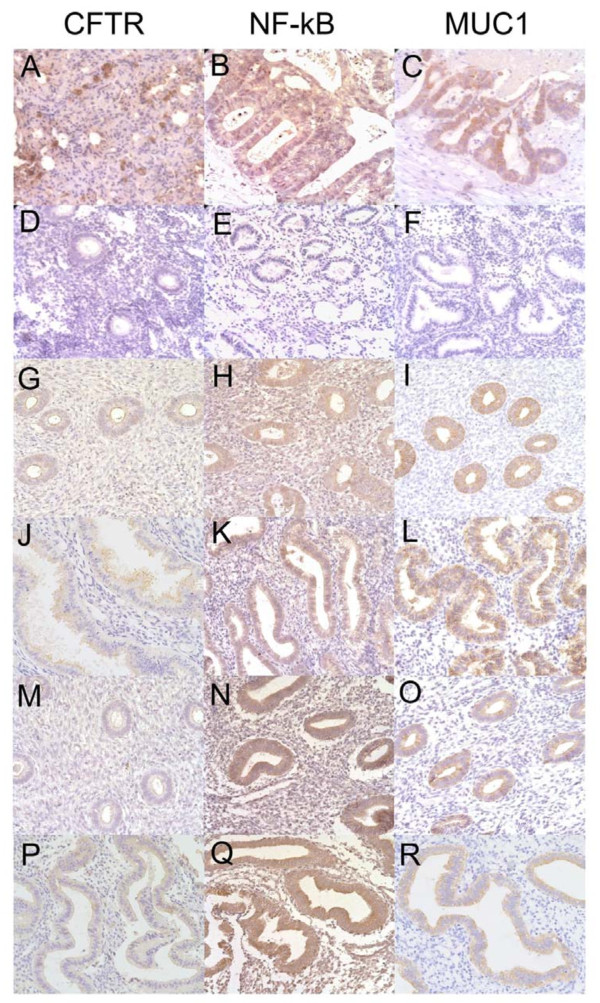
CFTR, NF KappaB and MUC1 immunohistochemical staining in the endometrium. Representative images of positive control CFTR, NF KappaB and MUC1 immunostaining (A-C) and negative control CFTR, NF KappaB and MUC1 immunostaining (D-F), respectively. CFTR, NF KappaB and MUC1 immunostaining in the endometrium of control infertile patients without a hydrosalpinx (G–L) and infertile patients with a hydrosalpinx (M–R). Endometrial tissues in the proliferative (D–I, M–O) and secretory (J–L, P–R) phases are shown for both groups; ×400 magnification.